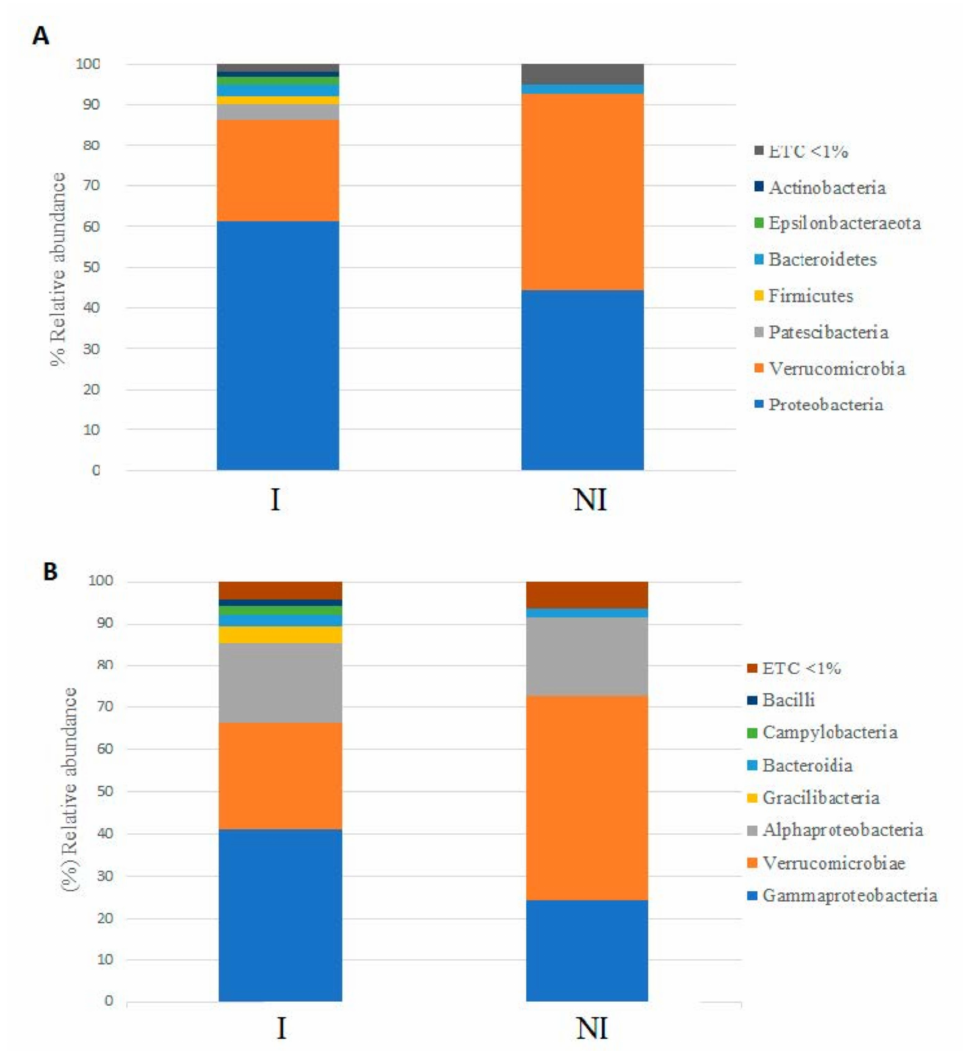
Figure 8. Relative abundance (%) of bacteria at the phylum ( A ), class ( B ), level in the skin mucus microbiota of non-infected (NI) and infected (I) fish. ETC: relative abundance < 1% in